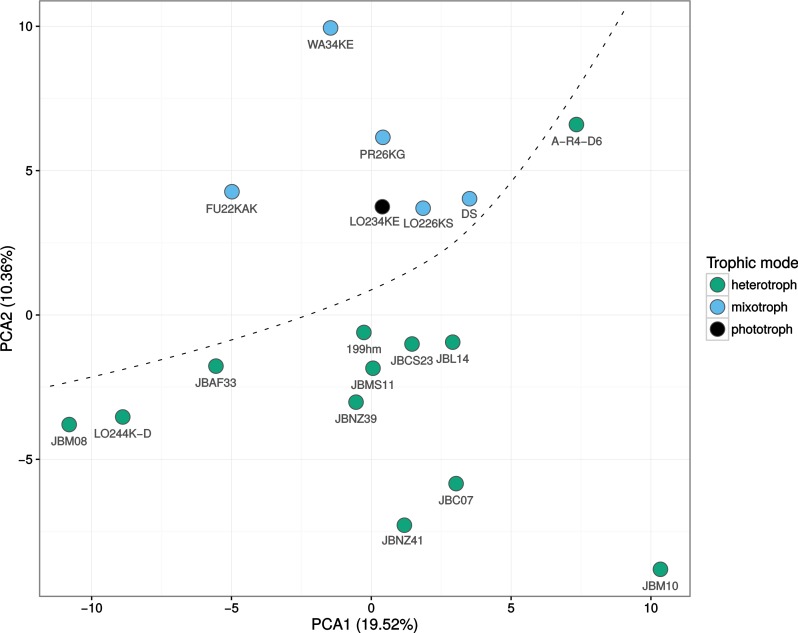
Principal component analysis (PCA) of normalized expression profiles.Depicted are the first and second component, which separate the mixotrophic (blue) and heterotrophic (green) strains, indicated by the dashed line, while the phototrophic (black) lies on the border of the mixotrophic group. The first and second component together explain 29.88% of the variance.